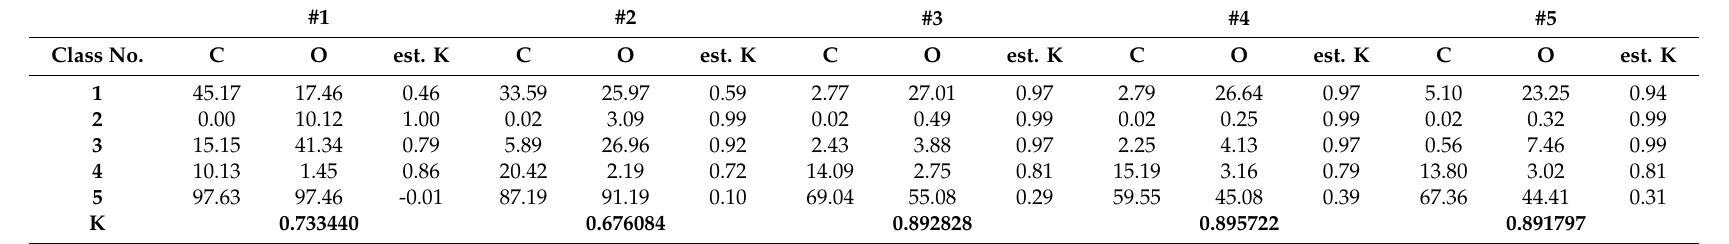
Table 9. The accuracy assessment of the random forest algorithm for the Osijek study